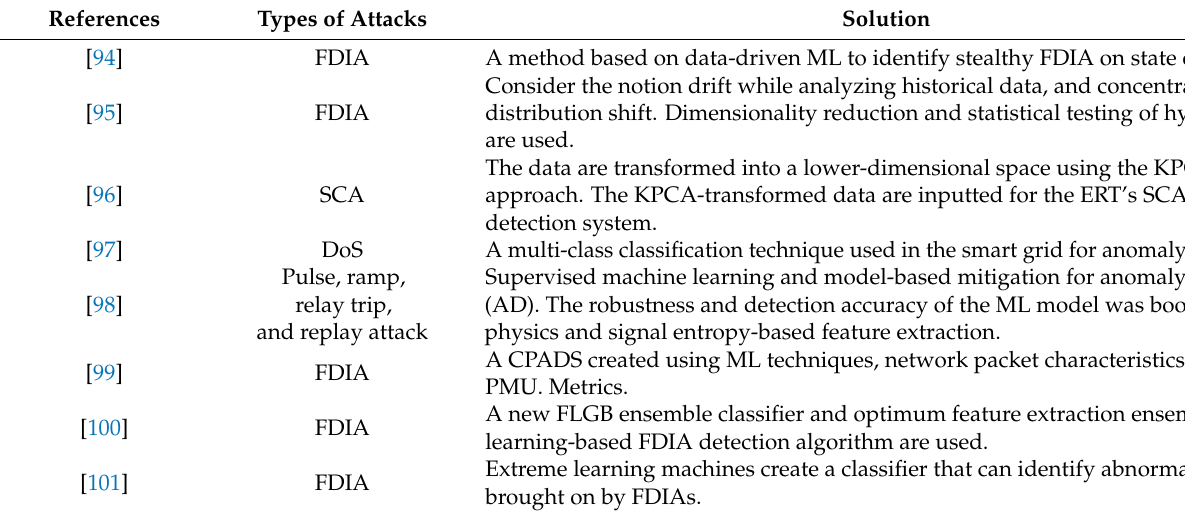
Table 5. Cyber-Attacks and Security